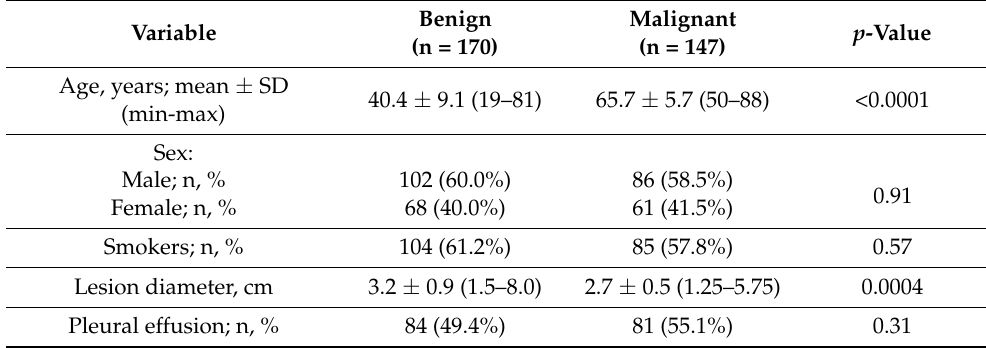
Table 1. Demographical and clinical characteristics of the patients in the